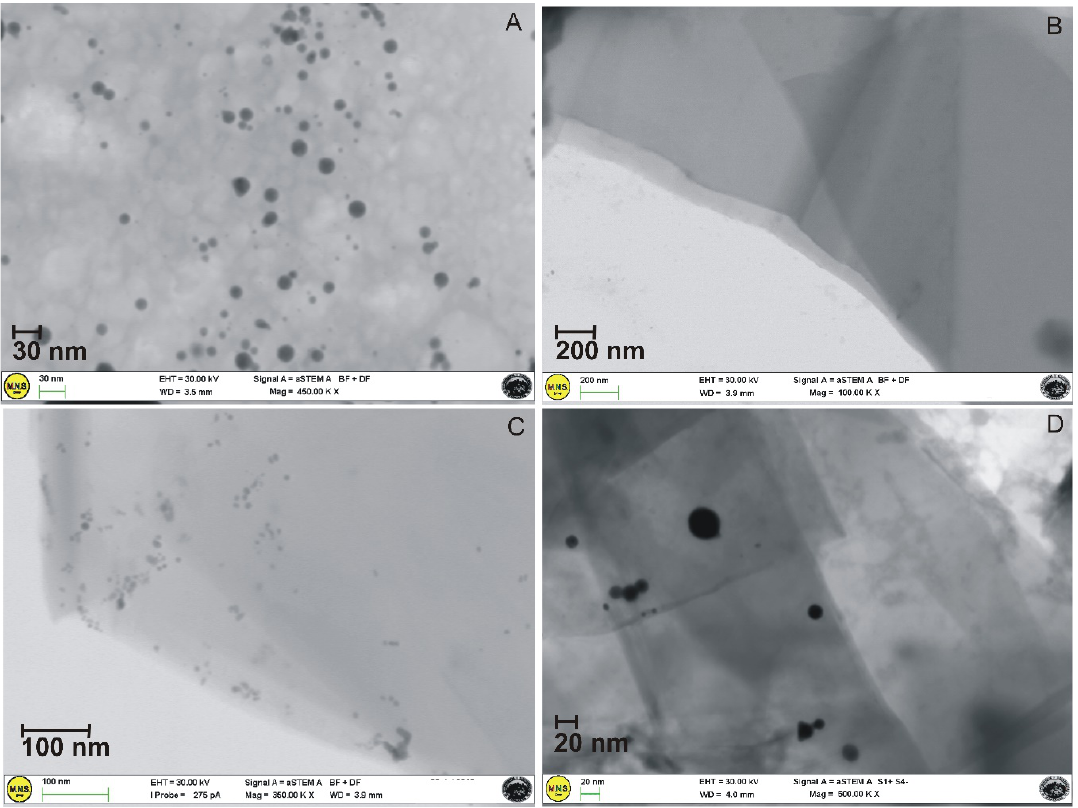
Figure 6. STEM images. ( A ) Au NPs produced by the green pulsed laser ablation technique in water at the laser fluence F of 1.5 J/cm 2 and the irradiation time t of 20 min. The NPs are nearly spherical in shape with a mean diameter of 15 nm; ( B ) G-NH 2 network with exfoliated G layers and transparent sheets, stacked onto each other, with a thickness of about 2–3 nm; ( C, D ) G-NH 2 /Au platform, with Au NPs embedded within the overlapped thin layers of graphene.